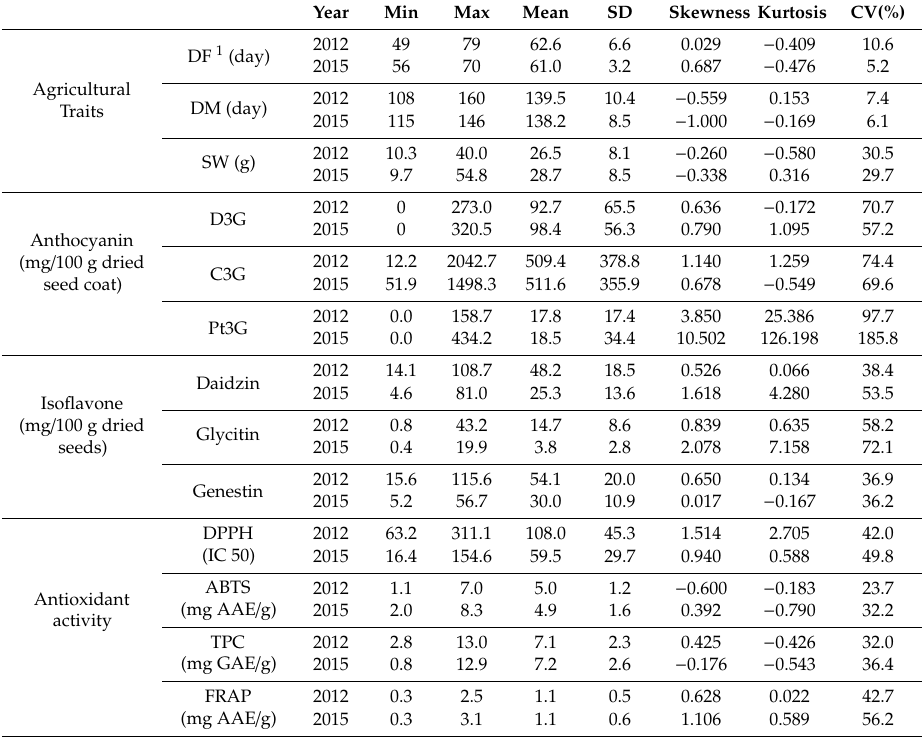
Table 1. Descriptive statistics of agricultural traits, phytochemicals, and antioxidant activity in 172 Korean black soybean landraces.